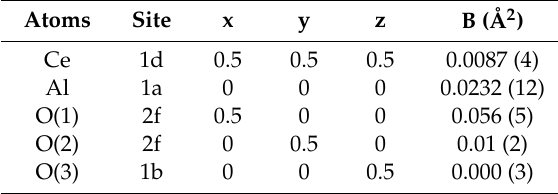
Table 1. Refined structural parameters for the as-grown CeAlO 3 crystal according to the P4/mmm model. Atoms Site x y z B (Å 2 ) Ce 1d 0.5 0.5 0.5 Table1. Refinedstructural parameters forthe as-grown CeAlO 3 crystalaccordingto theP4 / mmmmodel. Atoms